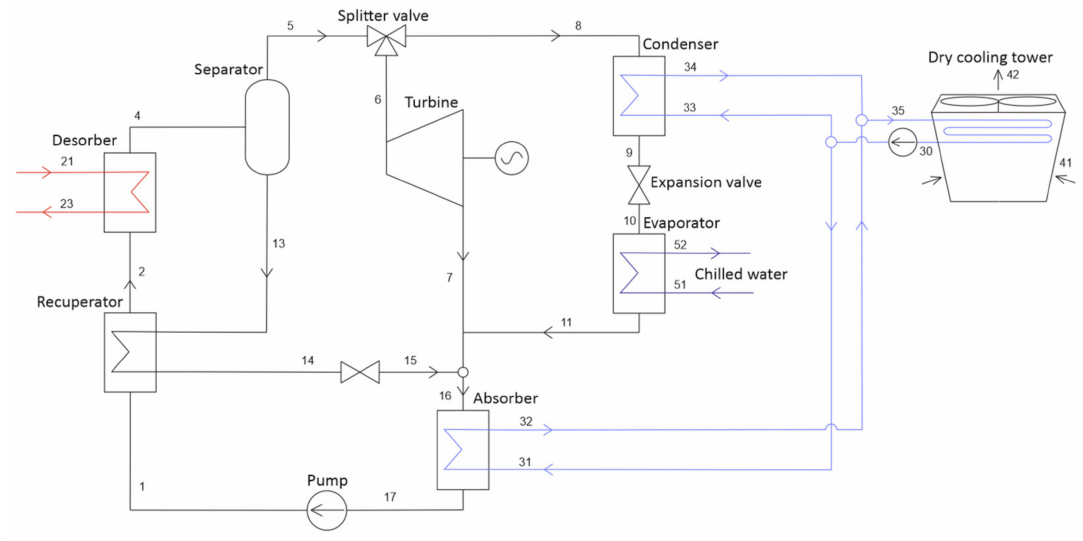
Figure 2. Schematic diagram of the proposed combined cooling and power